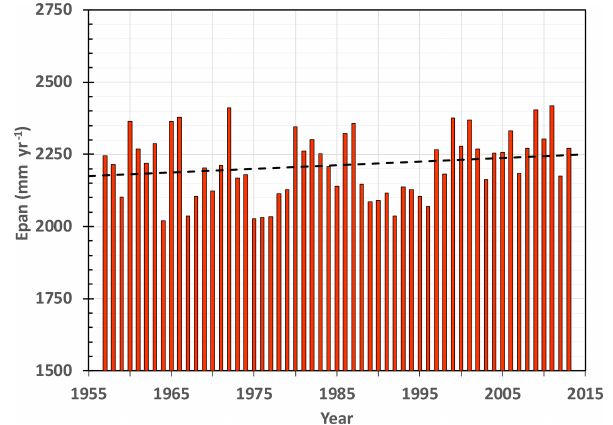
Figure 6. Area-averaged pan evaporation for the Hetao Basin, 1957 to 2013. The linear trend is not